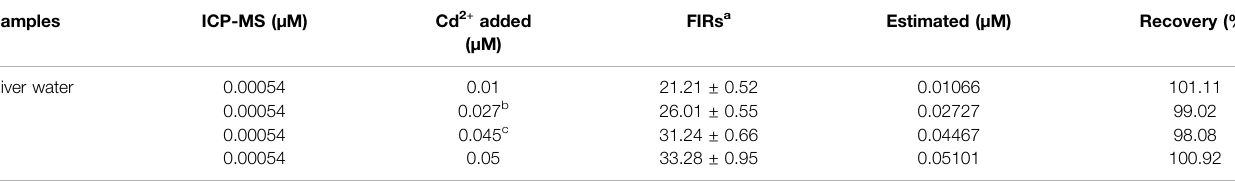
TABLE 1 | Accuracy and reliability of the constructed TCM biosensor in the measurement of cadmium in real river water samples.